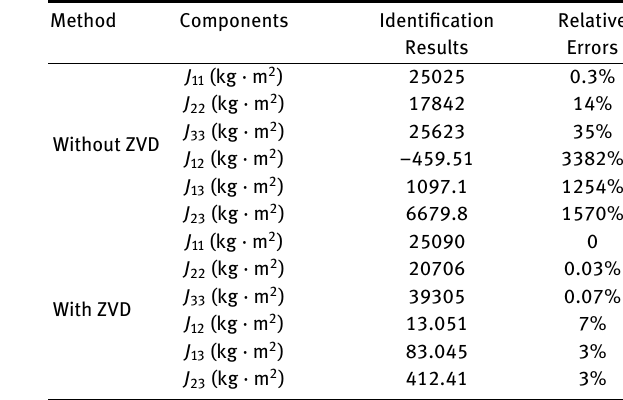
Figure 4. κ of 4 excitations